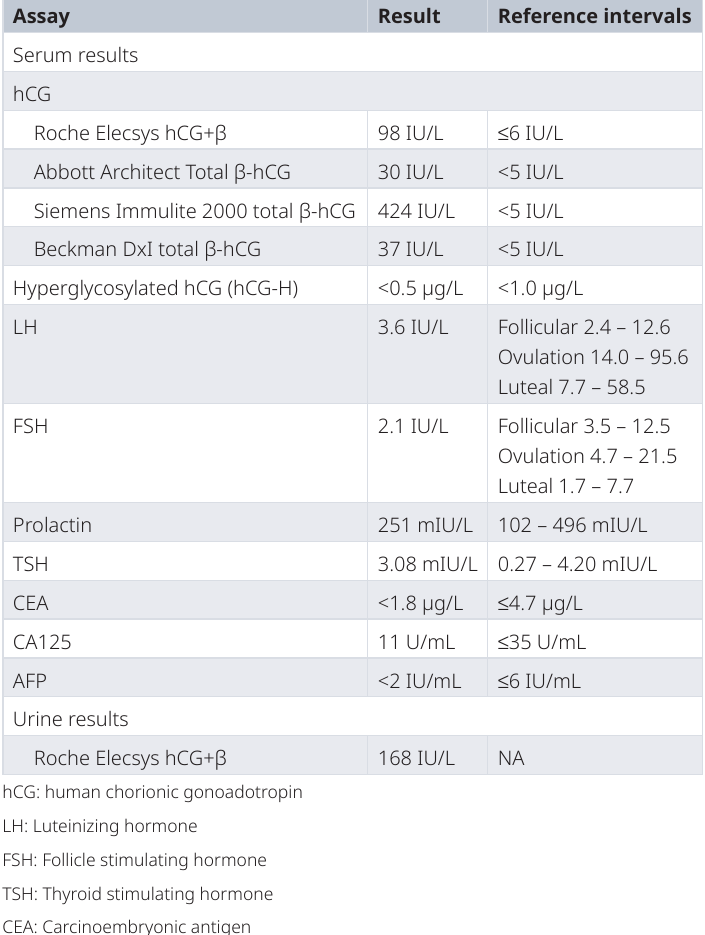
Table 1. Summary of biochemical results of the